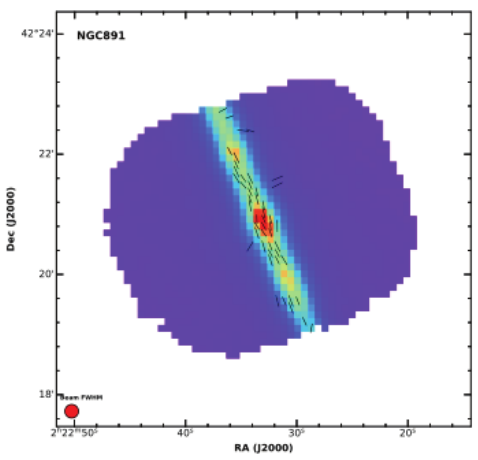
Figure 14. Total intensity map of the λ 154 μ m FIR continuum emission from the edge-on spiral galaxy NGC891 observed with SOFIA / HAWC + . The small bars show the polarization half- vectors rotated by 90 ◦ to trace the orientation of